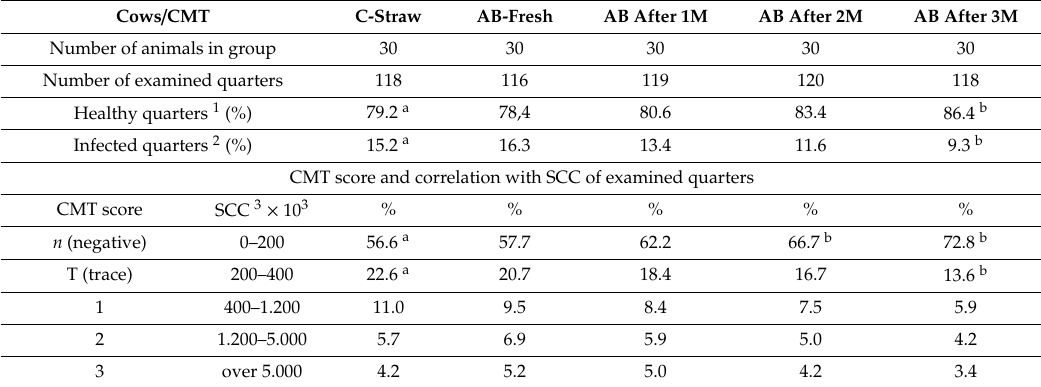
Figure 9. Comparison of bedding heights in cubicles. Note: C fresh straw—control cubicles were completely emptied of old straw bedding and layered with fresh straw; C straw—control cubicles were not emptied of straw bedding, but the cubicles were re-bedded once a day with fresh straw; AB-Fresh—cubicles bedded with one-day-old (fresh) alternative bedding; AB after 1M—one month after use of alternative bedding; AB after 2M—two months after use of alternative bedding; AB after 3M—three months after use of alternative bedding; a,b values above the column with di ff erent superscript letters di ff er significantly at p < 0.05. Table 1. Examination and evaluation of the California mastitis test (CMT) in monitored groups of